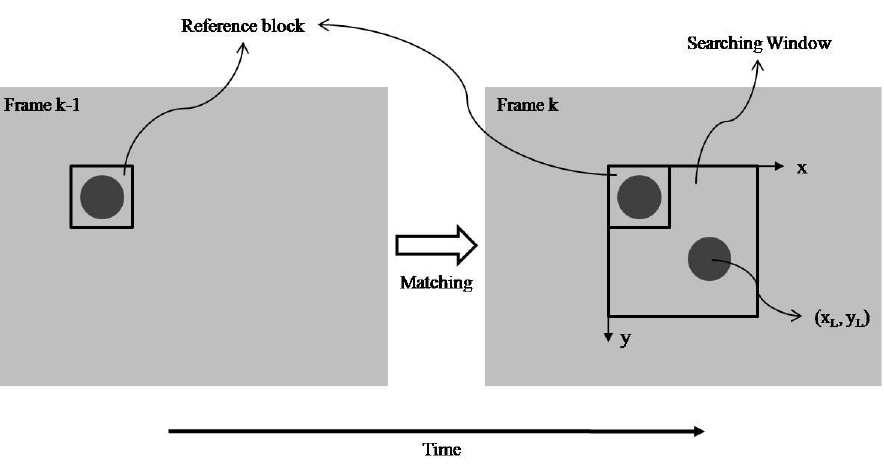
Figure 10. The block matching process.